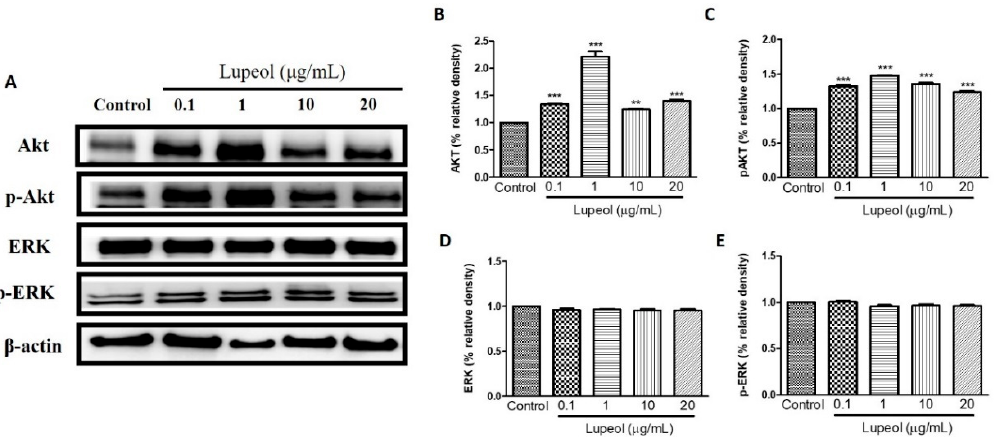
Figure 6. Lupeol regulates the expression of Akt and ERK in epidermal keratinocytes. ( A ) Western blot showing expression of Akt, p-Akt, ERK, and p-ERK in keratinocytes after 24 h treatment with lupeol in different concentrations. ( B – E ) All the proteins were semi-quantitated using ImageJ software and normalized to the levels of β -actin. Data are expressed as mean ± SEM. ** p < 0.01 and *** p < 0.001 versus control